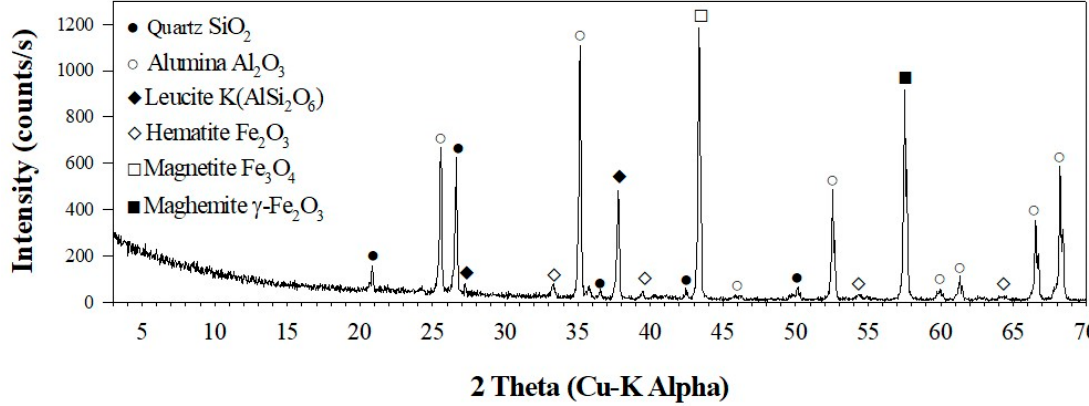
Figure 4. XRD pattern of the LFCM.